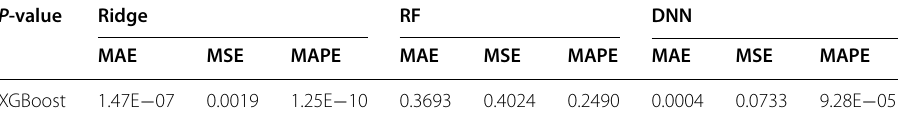
Table 3 P-values obtained from statistical hypothesis tests P ‑value Ridge